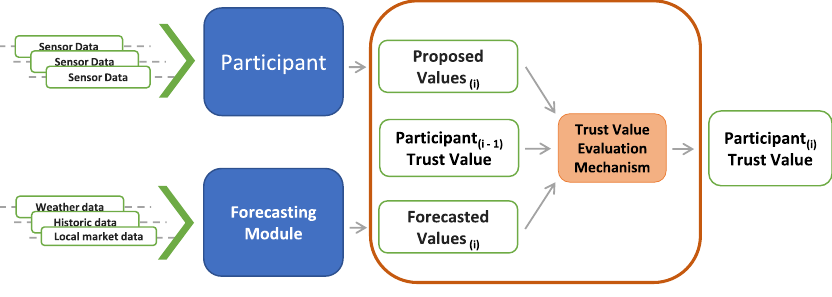
Figure 2. Trust evaluation